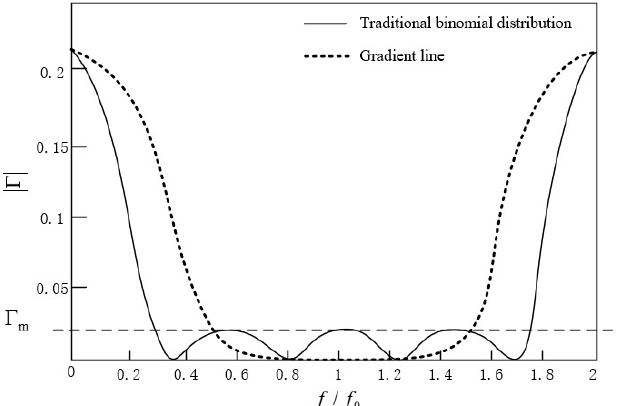
Figure 3. The relationship between the amplitude of the reflection coefficient and the frequency of the gradient line converter and traditional binomial distribution converter (fixed passband ripple of 0.02).